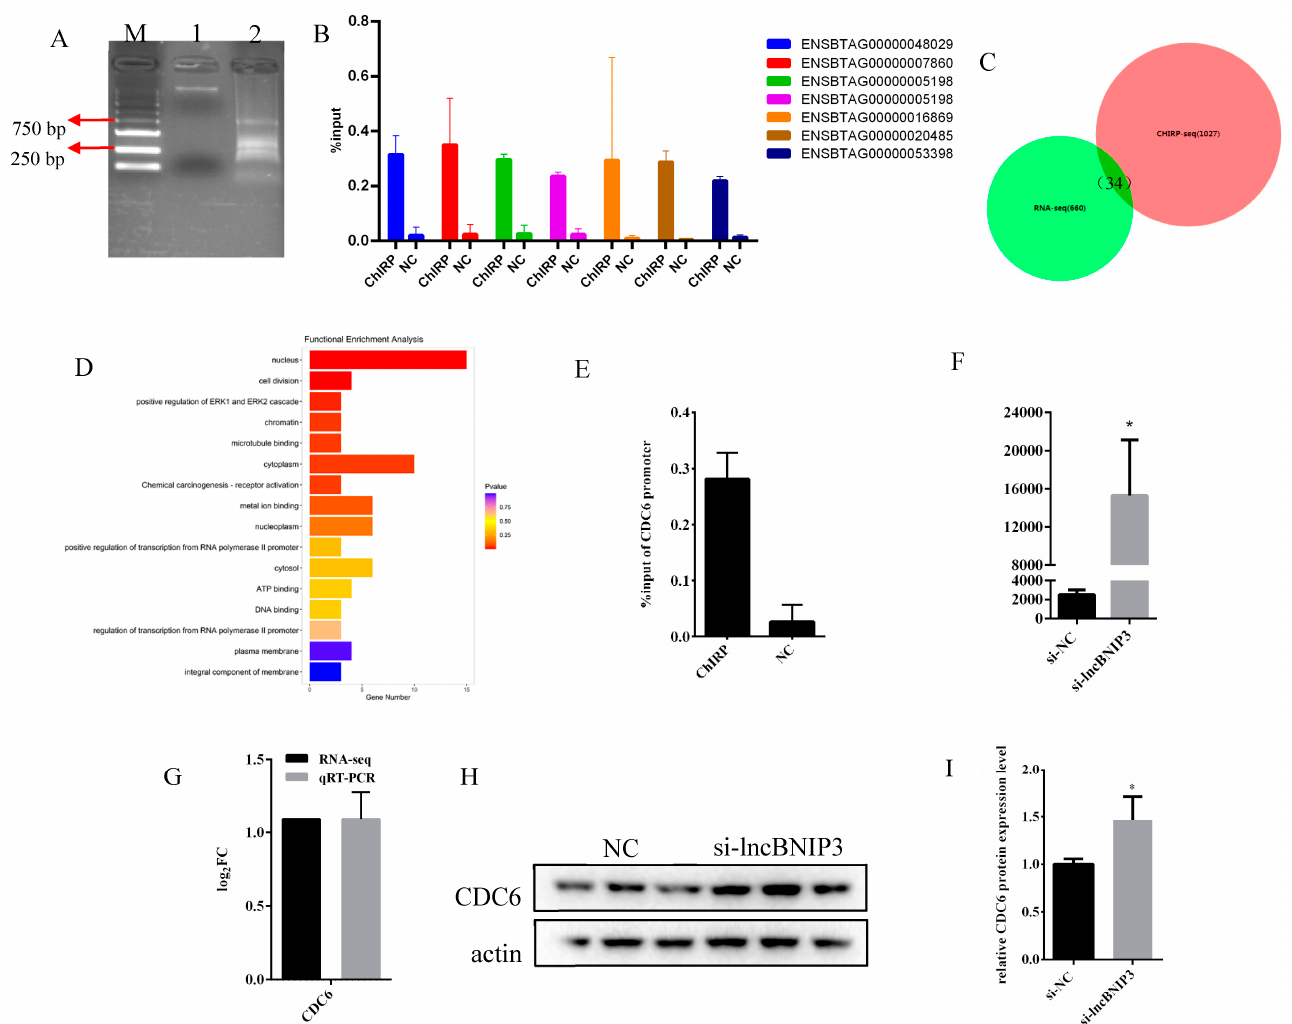
Figure 6. Interference with lncBNIP3 promoted the promoter activity and expression of CDC6. ( A ) Gel electrophoresis results of fragmentation products in the ChIRP test (M for Marker, from top to bottom are 5000 bp, 3000 bp, 2000 bp, 1500 bp, 1000 bp, 750 bp, 500 bp, 250 bp, 100 bp; 1 for gDNA; 2 for the fragmentation products ( B ) RT-qPCR results of the expression levels of 7 peaks in ChIRP group and NC group relative to input group; ( C ) The intersection analysis between the genes with peaks of ChIRP-seq on promoters and DEGs of RNA-seq; ( D ) Functional enrichment analysis of the intersection genes; ( E ) RT-qPCR results of the peak on CDC6 gene promoter region in ChIRP and NC groups relative to input group; ( F ) The results of luciferase activity of CDC6 gene promoter after transfecting si-lncBNIP3 and si-NC into the bovine intramuscular preadipocytes; ( G ) The fold changes of CDC6 mRNA expression after transfection, with si-lncBNIP3 and si-NC measured by RNA-seq and RT-qPCR; ( H ) Western Blot results of CDC6; ( I ) Statistical data of the Western blot results. Data are expressed as means ± SD. * indicated significant difference ( p < 0.05).